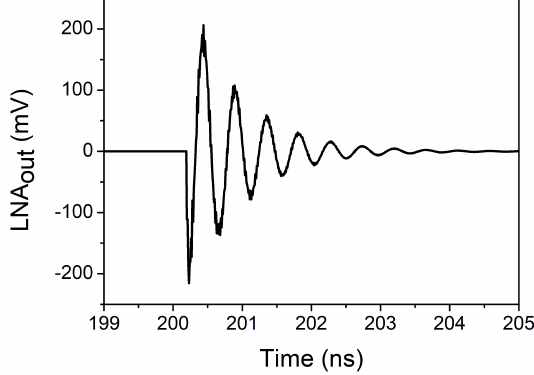
Figure 11. Effect of the pulse on the output of the LNA.